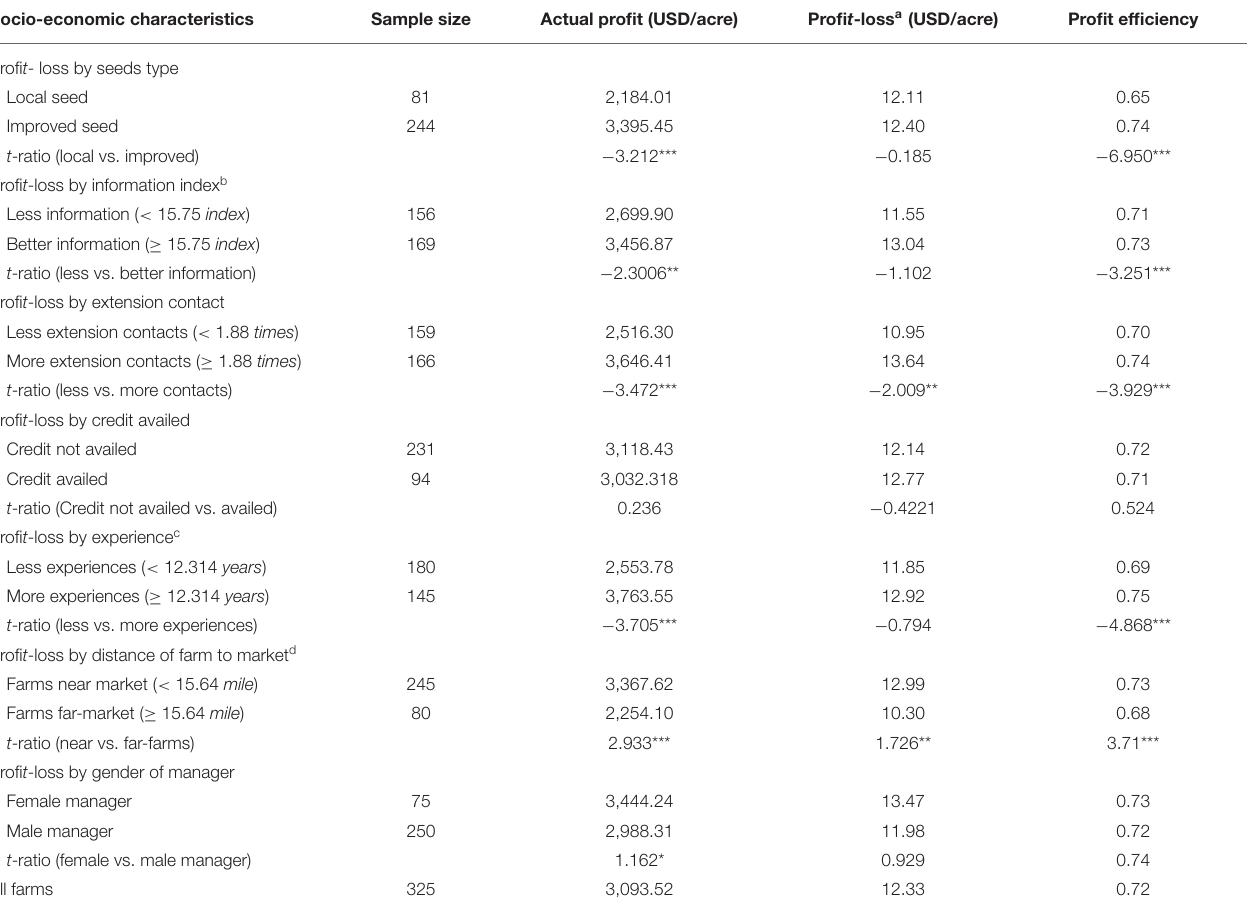
TABLE 5 | Average profit, profi t -loss, and profit efficiency by socio-economic variables. Socio-economic